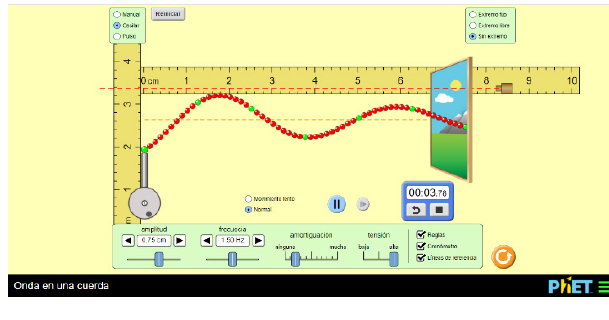
Fig. 10. Wave on a